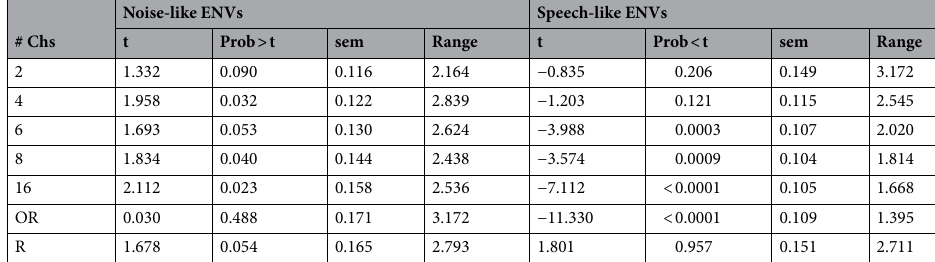
Table 1. Response Bias statistical analyses. For each tested condition (first column), we provide details of the statistical analyses (t-value, p-value, sem, Range) for chimaera and control conditions with noise-like (left main column) and speech-like (right main column)